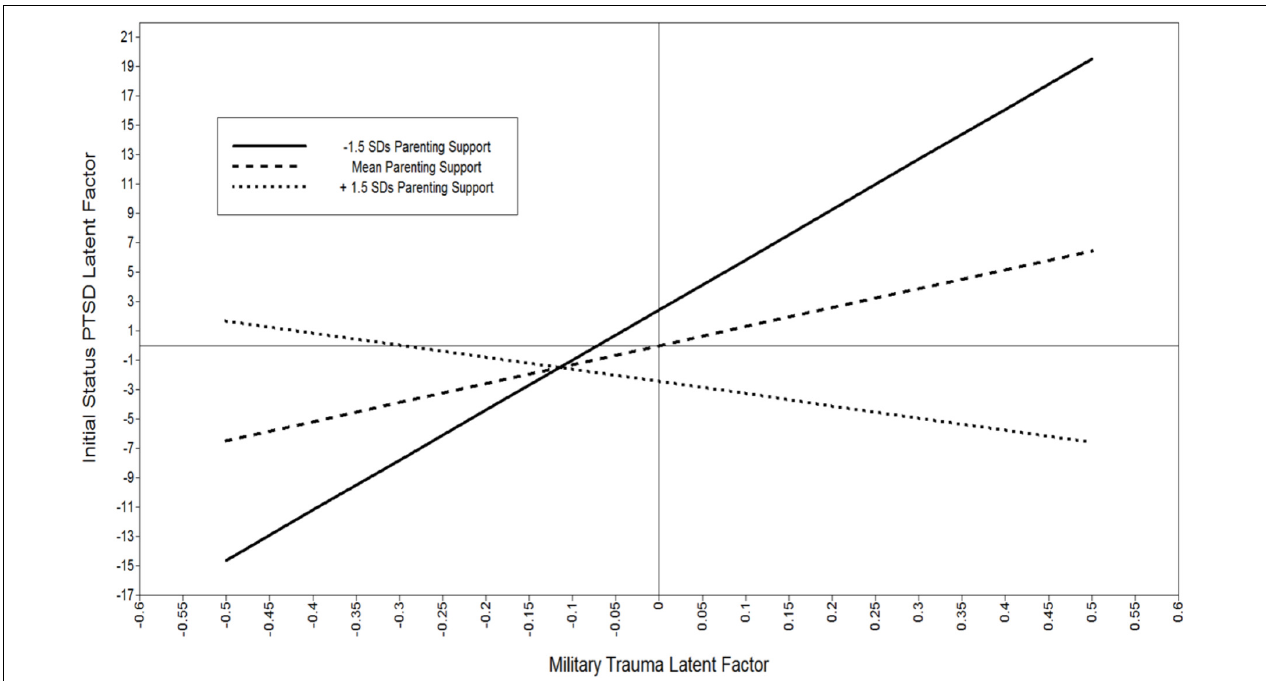
FIGURE 6 | Plot of moderating effect of parenting support on the negative impact of trauma on PTSD symptoms for military mothers. Both the trauma factor and PTSD factor are centered latent variables; zero represents the factor mean. The estimated “region of significance” and bootstrapped confidence intervals indicated that parenting support reduced trauma’s impact starting at 0.45 standard deviations of support for mothers. That is, above half a standard deviations there was a non-significant effect of Trauma on